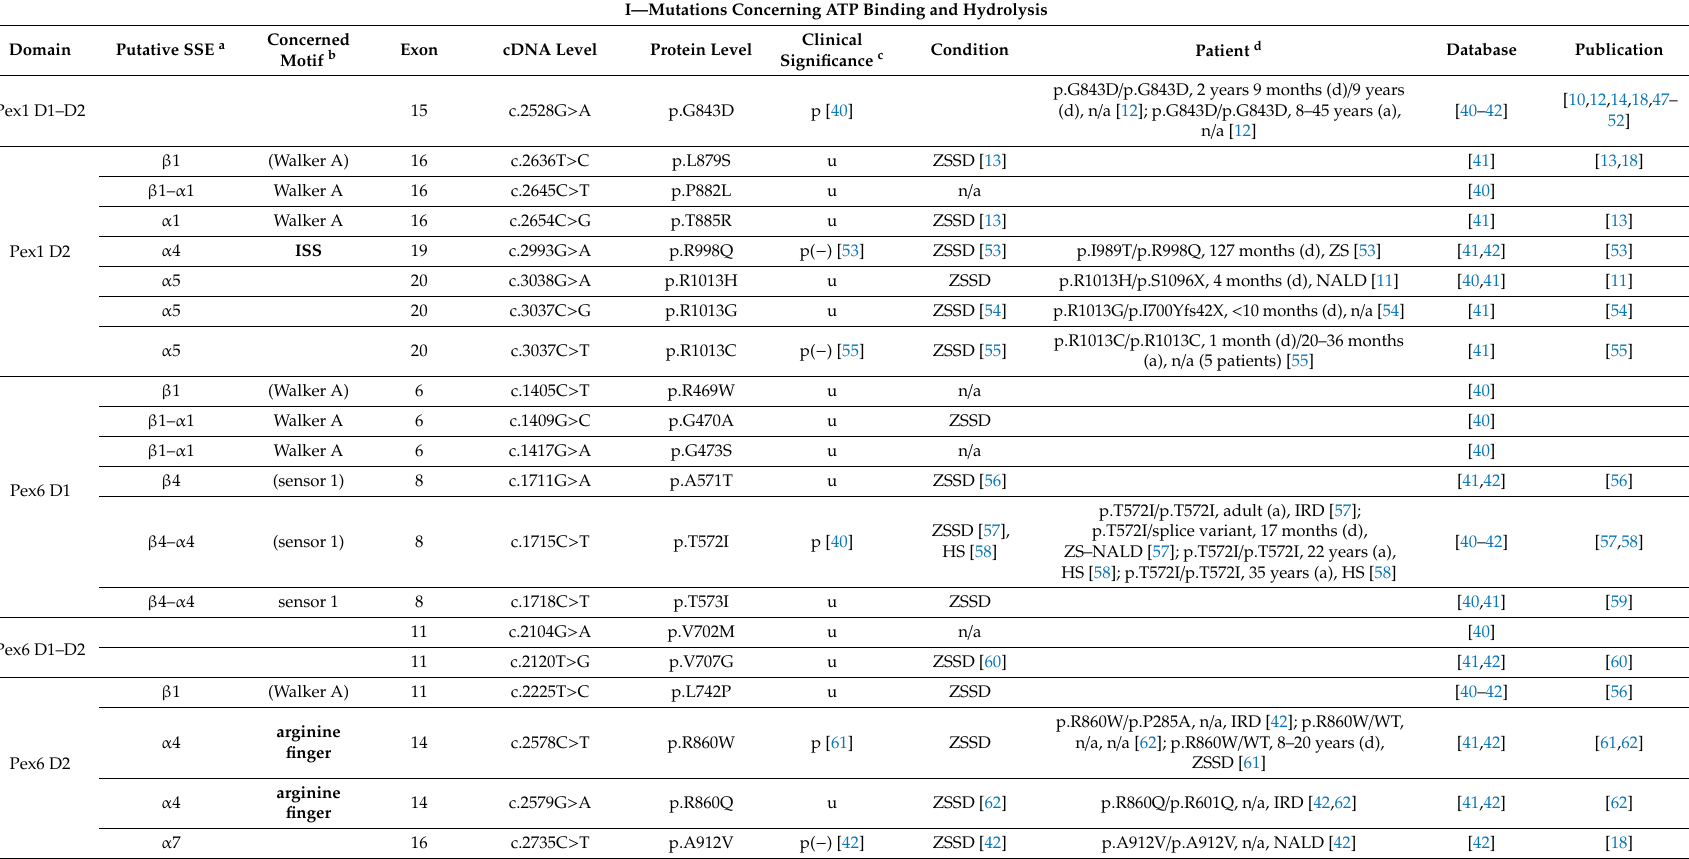
Table 1. Mutations of the Pex1 / Pex6 complex reported from Zellweger syndrome spectrum disorder (ZSSD) patients that are discussed in this study. Mutations were collected from databases ClinVar, Human Genome Mutation Database (HGMD), and Leiden Open Variation Database (LOVD) and publications. The mutations are grouped into four categories: ( I ) mutations concerning ATP binding and hydrolysis, ( II ) mutations concerning substrate interaction, ( III ) mutations concerning the interaction between Pex1 and Pex6, and ( IV ) mutations concerning the interaction with